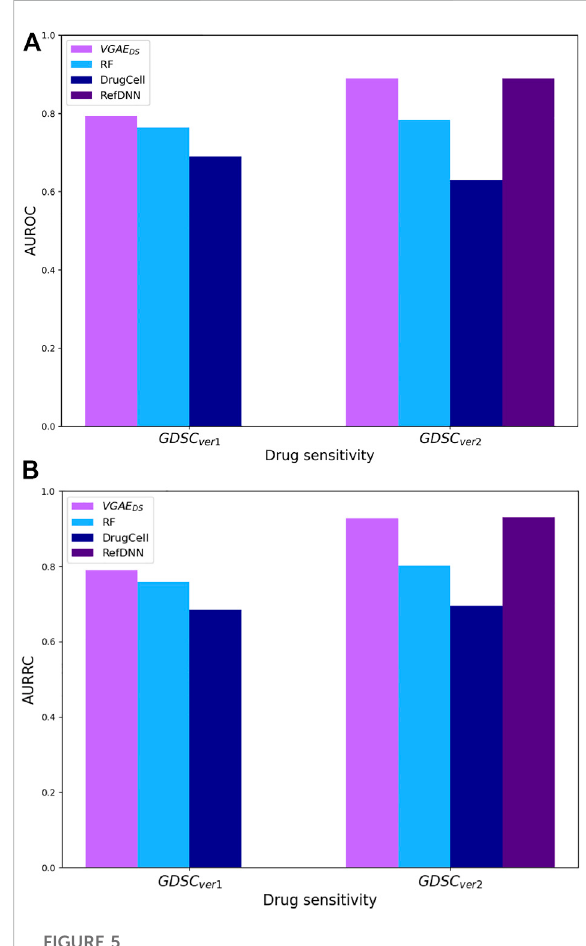
FIGURE 5 Prediction performance on drug sensitivity data. (A) AUROC results. (B) AUPRC